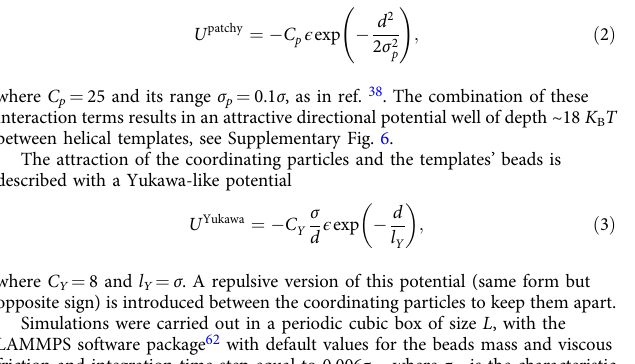
Fig. 11. This match con fi rms the predictive capabilities of the enumerative scheme of Fig.